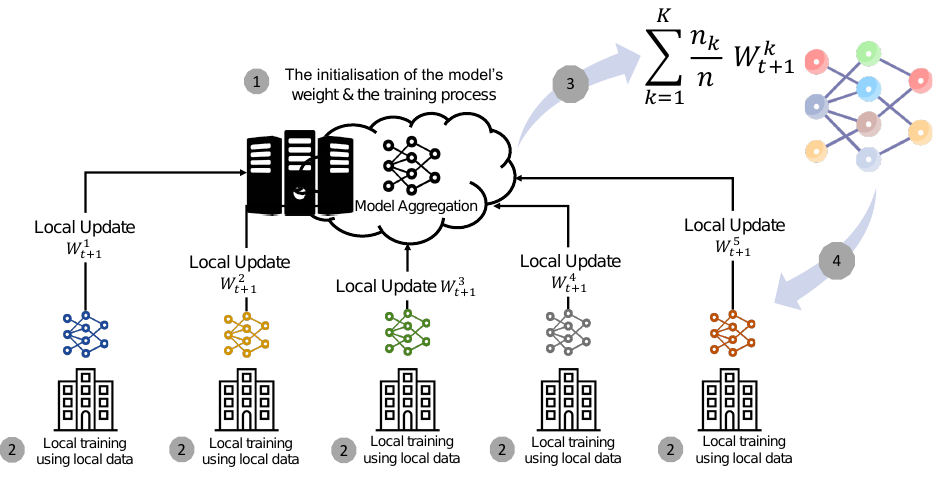
Figure 4. FL process.